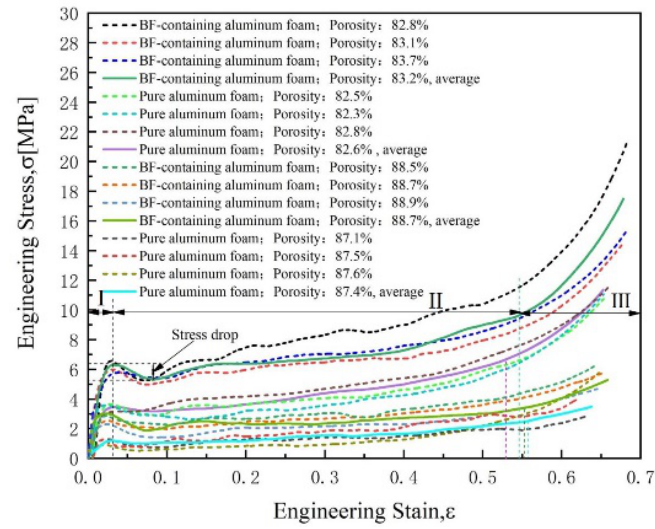
Figure 2. Stress–strain curves of two kinds of aluminum foams.